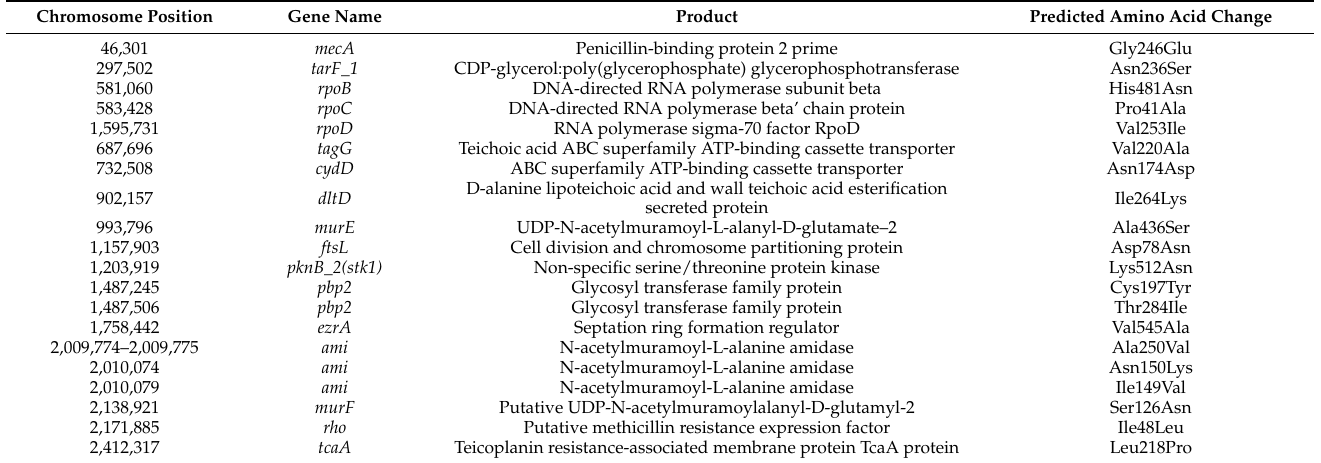
Table 4. Non-synonymous SNPs related to peptidoglycan metabolism or vancomycin reduced susceptibility shared among all strains analyzed in this study, after mapping the reads to the S. aureus N315 reference genome. All changes are expressed in reference to the S. aureus N315